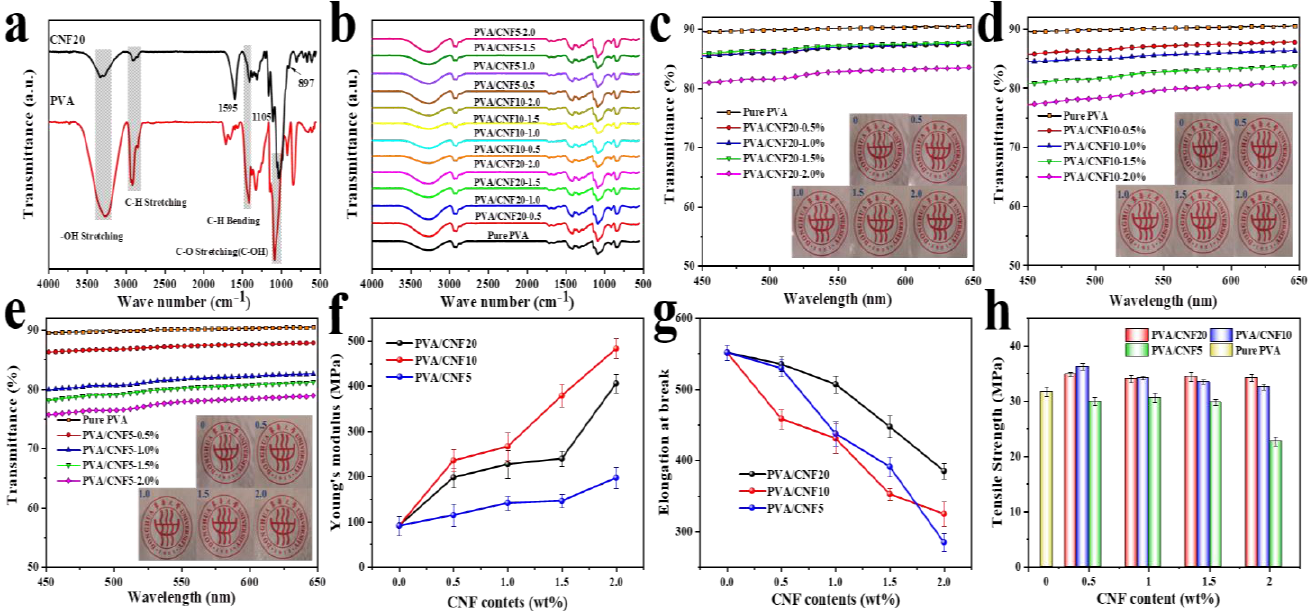
Figure 4. FTIR: ( a ) CNF20 and PVA films; ( b ) PVA/CNF composites with different additions of CNFs with different lengths; UV-vis spectrum of PVA/CNF composites: ( c )PVA/CNF20;( d ) PVA/CNF10; ( e ) PVA/CNF5; Mechanical properties of PVA/CNF composites: ( f ) Young’s Modulus; ( g ) Elongation at break; ( h ) Tensile strength.